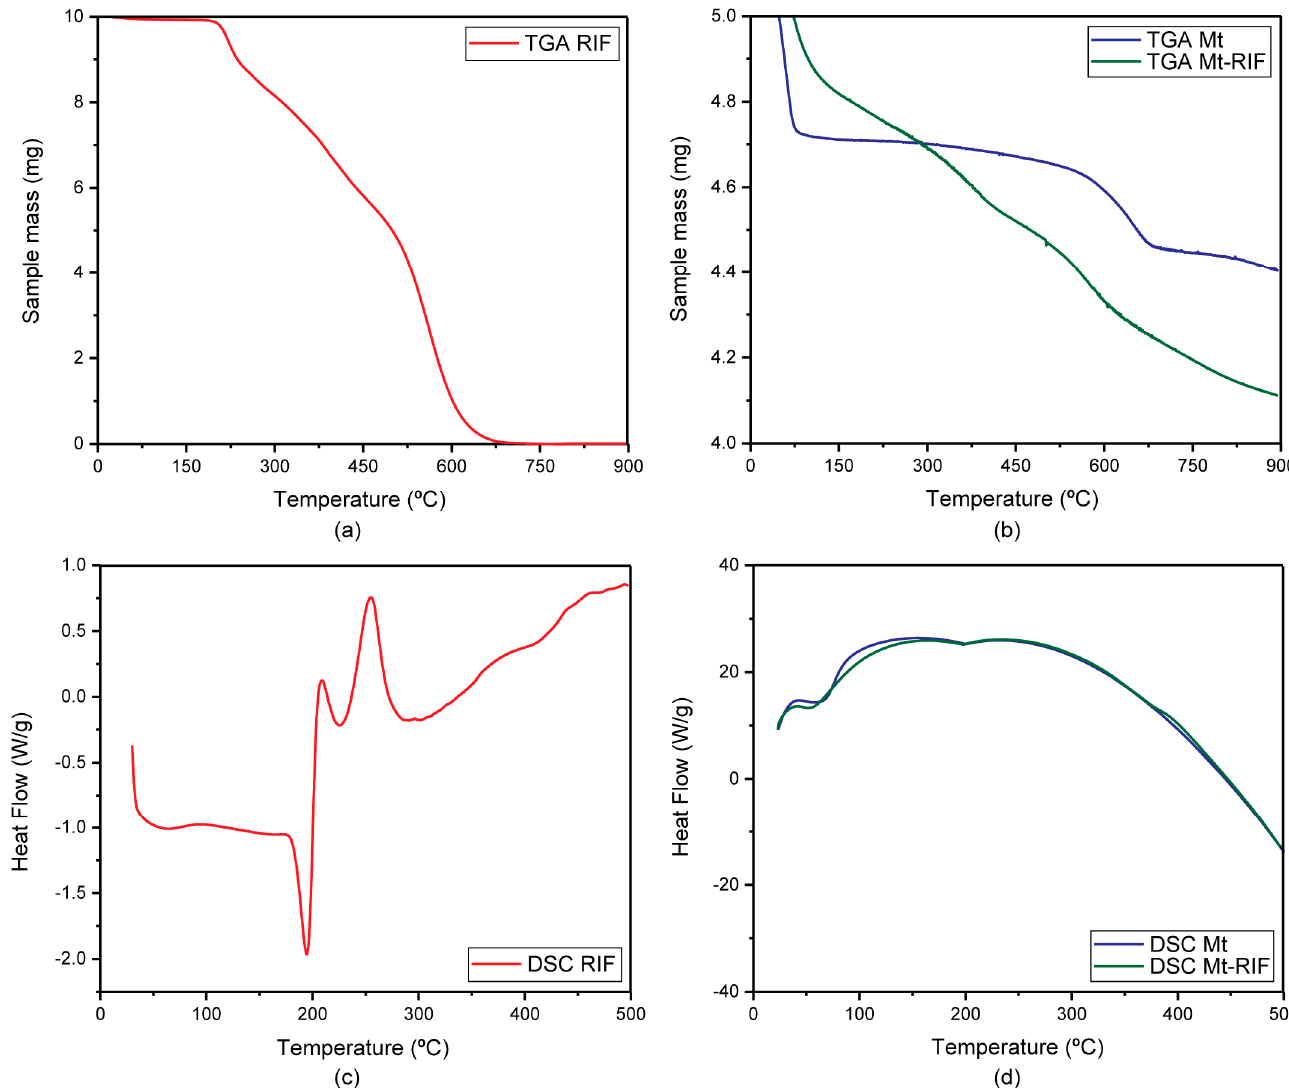
Figure 6. TGA curve for ( a ) RIF and ( b ) Mt (in blue) and Mt–RIF hybrid (in green). DSC curve for ( c ) RIF and ( d ) Mt (in blue) and Mt–RIF hybrid (in green).